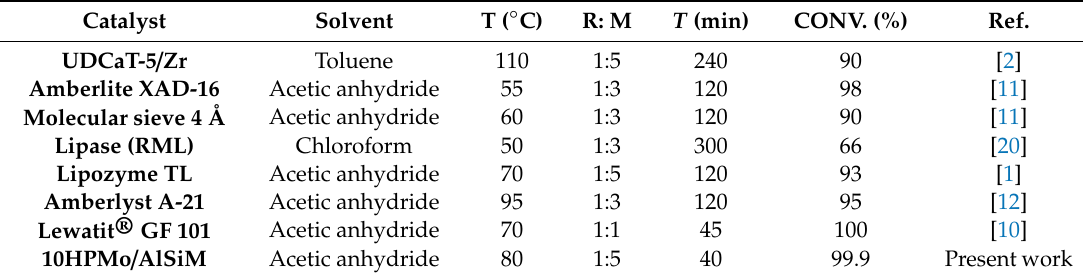
Figure 10. Effect of time on acetylation reaction. Reaction conditions: 1:5 molar ratio (EugOH: AA), 80 °C and 2% catalyst. Table 6. Comparison of eugenol conversion with reported catalyst.